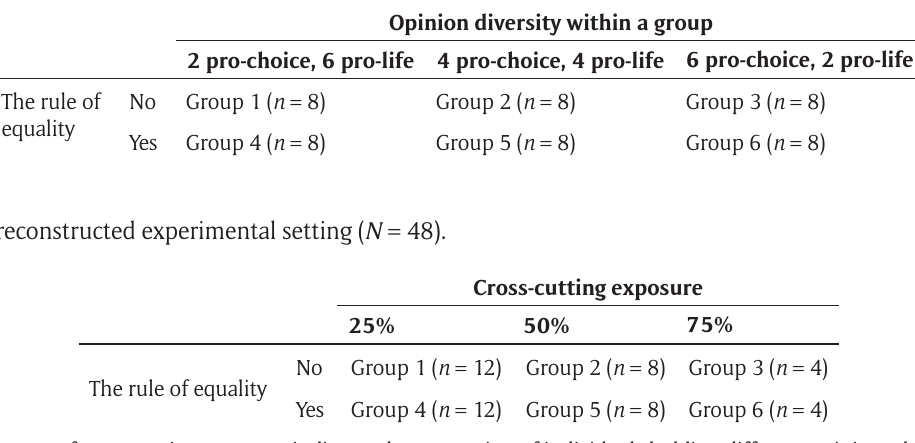
Note . The percentage of cross-cutting exposure indicates the proportion of individuals holding different opinions that an individual encounters in a discussion